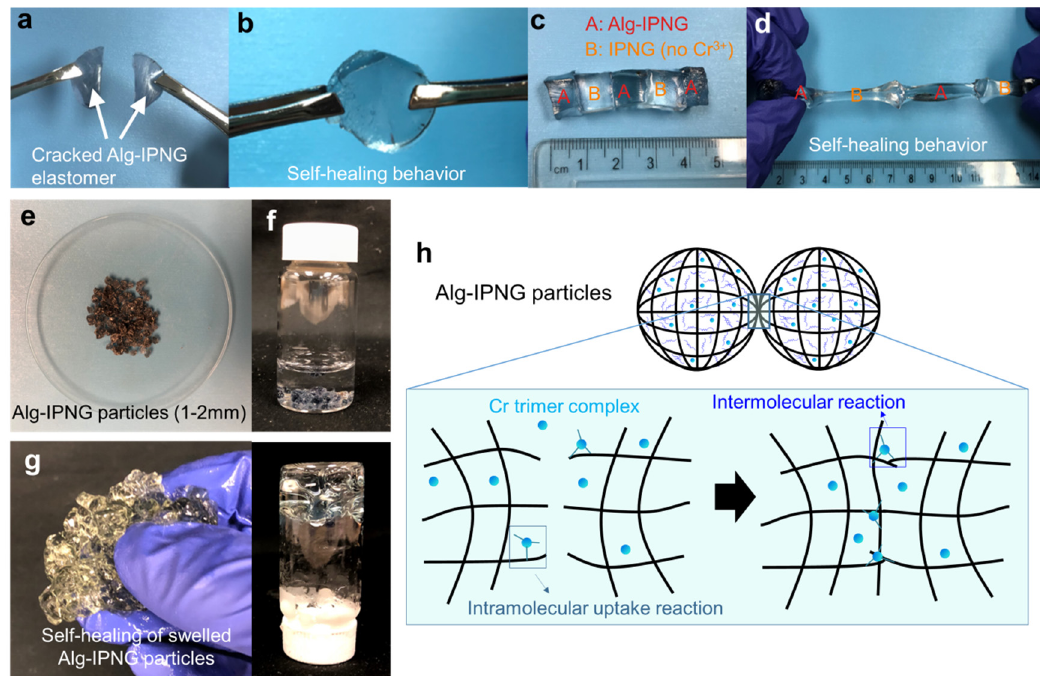
Figure 3. Self-healing of the Alg-IPNG gel: ( a , b ) self-healing of a broken Alg-IPNG gel; ( c , d ) self-healing between Alg-IPNG and IPNG gels; ( e – g ) photograph of the Alg-IPNG particles; ( h ) schematic illustration of the self-healing process of the Alg-IPNG gel—delayed self-healing by chromium trimer complexes at the contact interfaces of the gel.